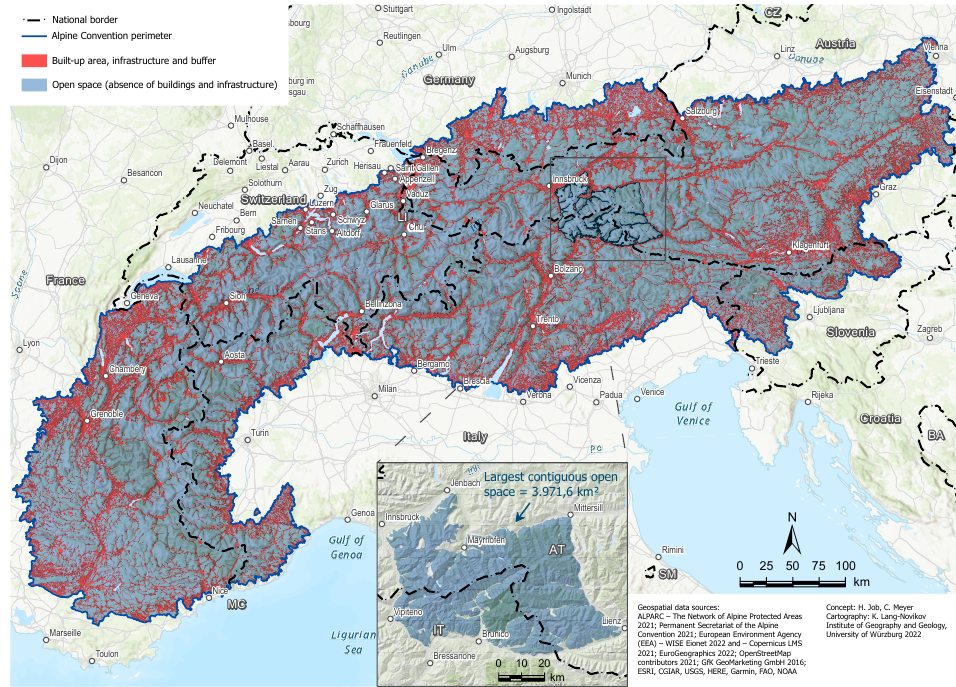
Figure 1. Binary open space analysis (source: authors’ figure, based on ALPARC